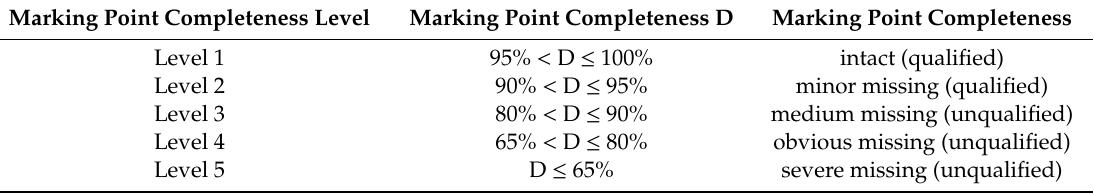
Table 2. Completeness rating standards of the solid and hollow circle marking